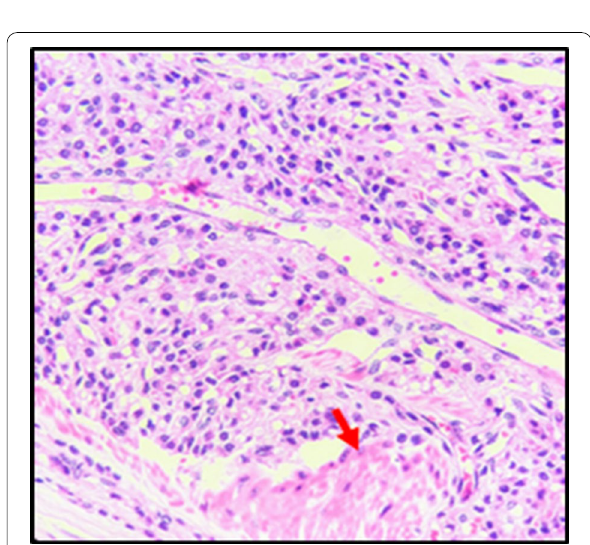
Fig. 6 Monomorphous polygonal cells arranged in solid nests, intersected by delicate fibrovascular septae and involving the deep muscle fibers (red arrow). H&E